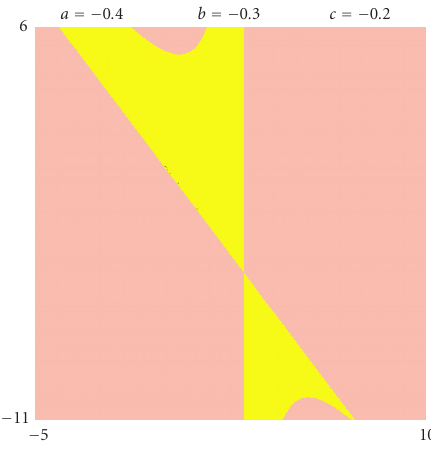
Figure 4.7. Iterates of focal point on the boundary of the